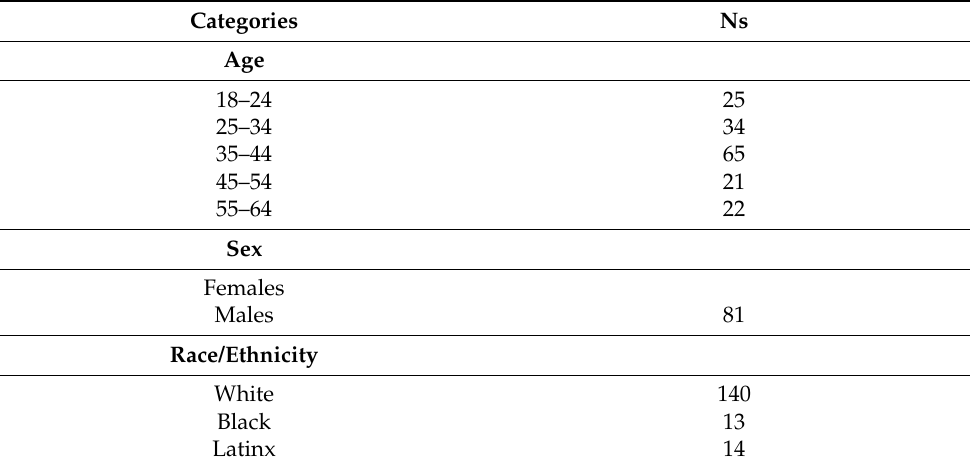
Table 4. Demographic characteristics of the participants included in Study 2 (N =